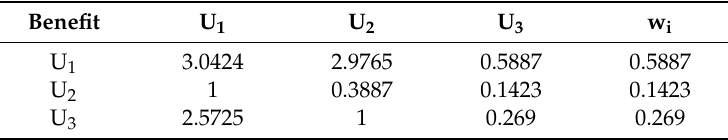
Table 4. Revised weight matrix of comprehensive benefits.